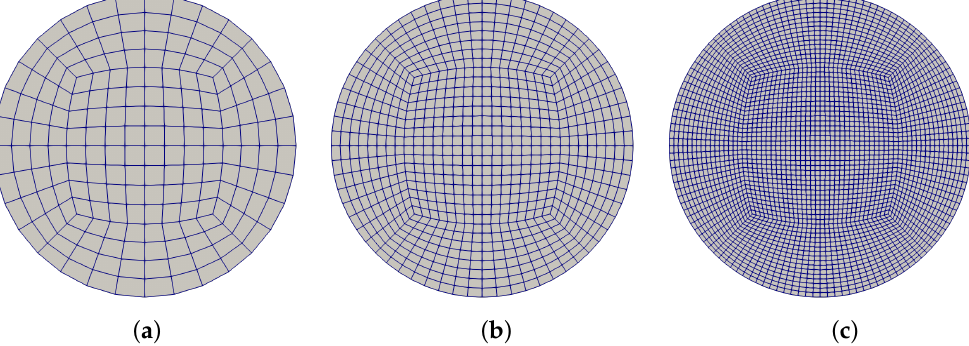
Figure 4. Internal mesh arrangement with no guidance blades. ( a ) coarse mesh (left); ( b ) intermediate mesh (center) and ( c ) fine mesh (right) are